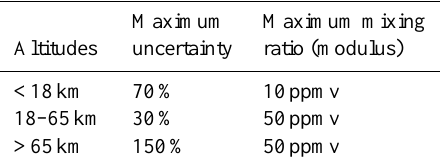
Table C1. Upper limit for allowed uncertainty and mixing ratio. All values larger than these thresholds are